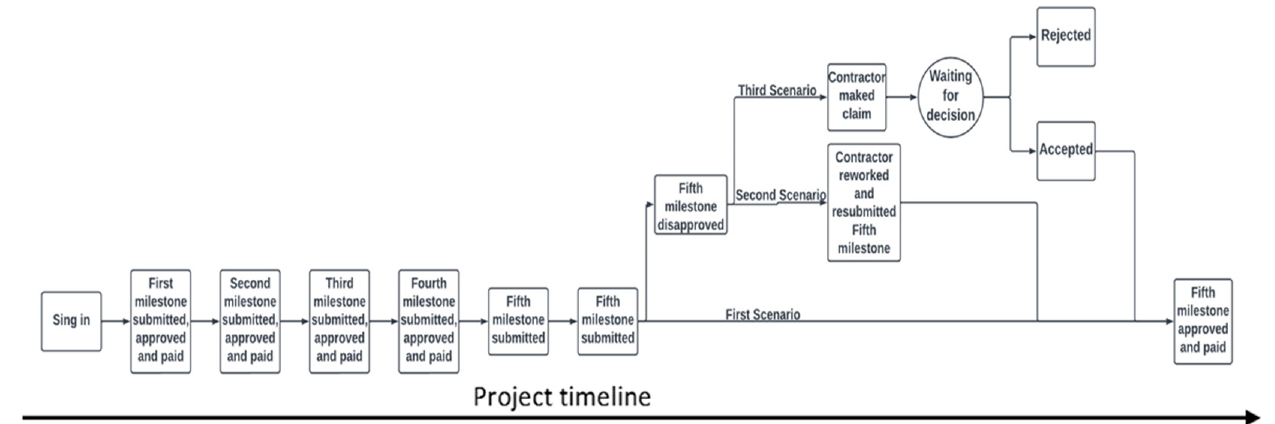
Figure 9. Prototype interface of a sample of submission, approval, and payment in the first mile- stone.